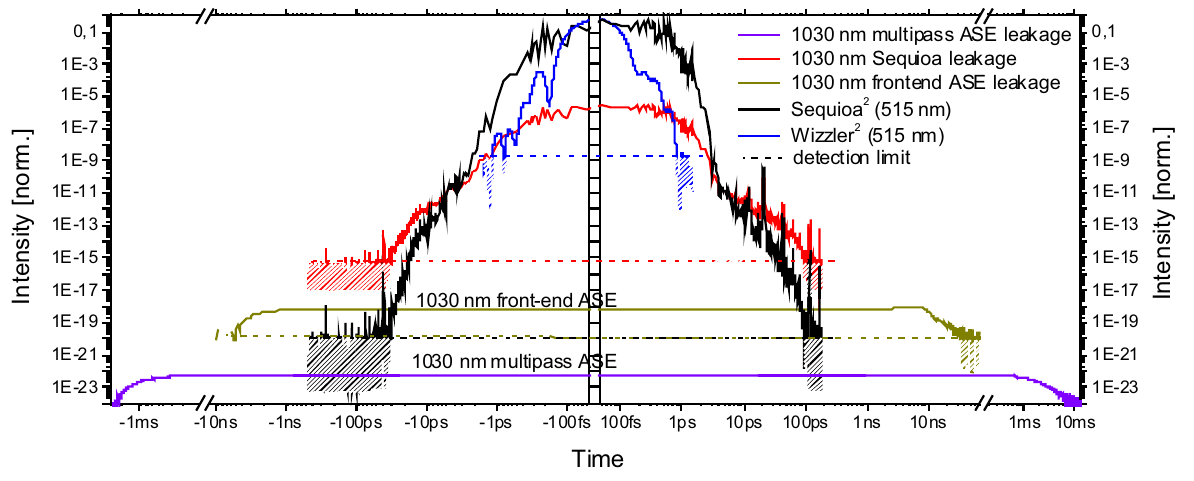
Figure 4. Measured and calculated temporal characterization of the on target intensity taking SHG and fundamental pulses into account. Negative times are defined as the times before the laser pulse. Black: converted THG-correlation for 515 nm. Blue: converted self-referenced spectral interferometry (Wizzler, Fastlite) measurement for 515 nm. Red: converted THG-correlation for 1030 nm. Ocher: Converted photodiode measurement for the 1030 nm frontend amplified spontaneous emission (ASE). Dark blue: Converted photodiode measurement for the 1030 nm multipass ASE. The detection limit of each measurement is marked as a dashed